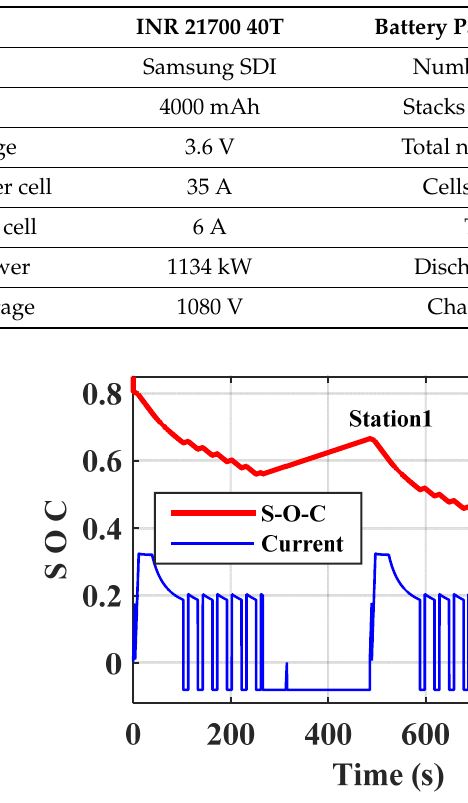
Table 2. Configuration and specification of the battery for hybridization with FC.